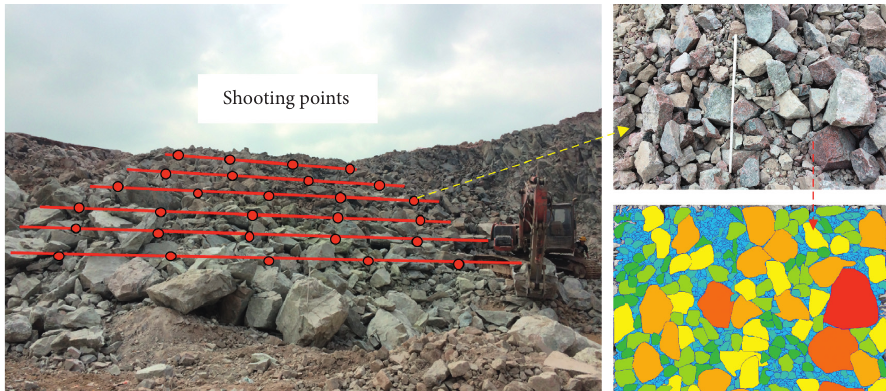
Figure 11: Image recognition method of fragment size distribution of muck pile.